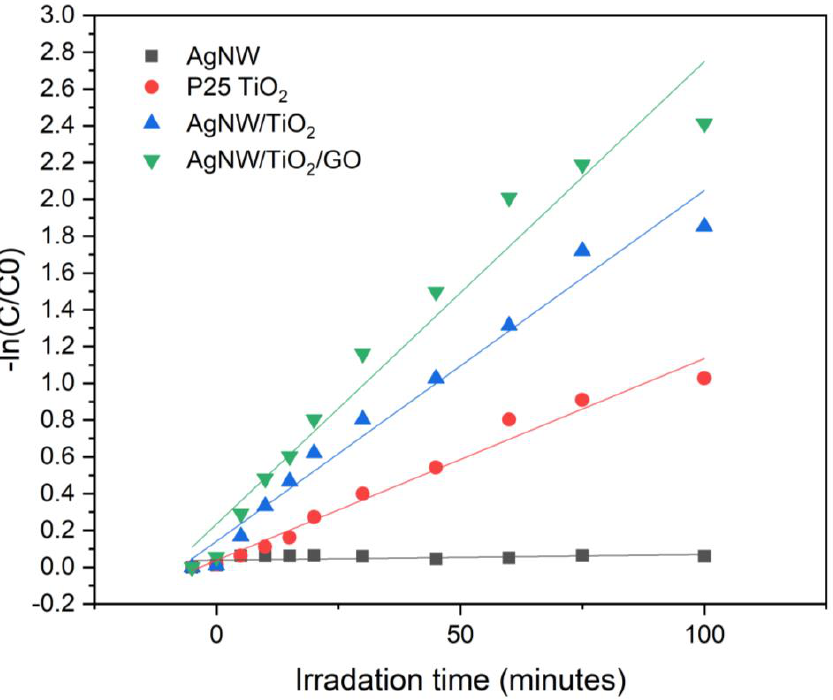
Figure 10. First-order kinetic curves of RhB degradation with AgNW, AgNW/TiO 2, and AgNW/TiO 2 /GO nanocomposite